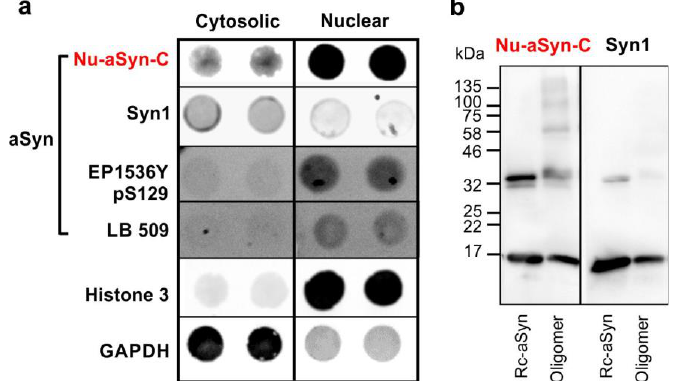
Figure 3. ( a ) Dot blot analysis of enriched cytosolic and nuclear fractions from H4 cells using different anti-aSyn antibodies, including Nu-aSyn-C, Syn1, EP1536Y (specific for phosphorylated aSyn on serine 129), and LB 509 (recognizing aggregated aSyn). GAPDH and histone 3 serve as protein markers of the cytosol and the nucleus, respectively. In H4 cells, nuclear aSyn exhibits a higher phosphorylated and aggregated status than cytosolic aSyn. ( b ) WB analysis of human recombinant aSyn (Rc-aSyn) and preformed aSyn oligomers. The Nu-aSyn-C antibody preferentially recognizes higher-molecular-weight